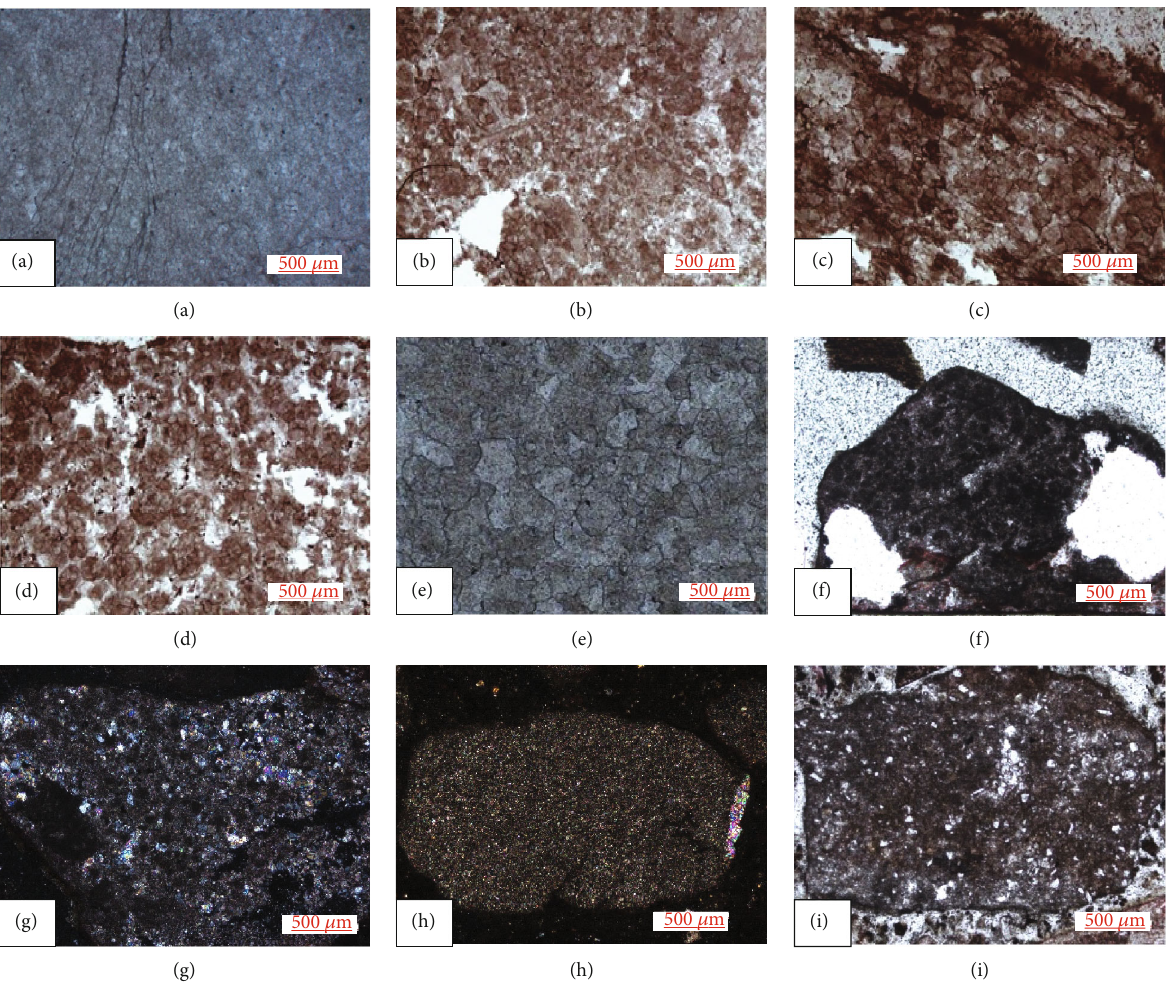
Figure 4: Petrological characteristics of dolomite in DEPS. (a) Muddy-pink dolomite, Wutan 1 Well, 6265 m, Xixiangchi Formation, 10 × 5(-), chip stained thin section; (b) fi ne-crystal dolomite, residual grain phantom, dissolved pores, quartz crystal, Wutan 1, 6907m, 10 × 5(-); (c) fi ne-grained dolomite, oolitic phantom, intercrystalline pores, Wutan 1 Well, 6921 m, 10 × 5(-); (d) oolitic dolomite, with intergranular and intergranular (dissolved) pores, asphalt impregnation, fi ne-grained structure, Wutan 1 Well, 6916m, 10 × 5(-); (e) residual oolitic dolomite, Loutan 1 Well, 6903 m, 10 × 5(-); (f) sandy dolomite, Wutan 1 Well, 6562m, Xixiangchi Formation, 10 × 5(-), cuttings stained thin section (g) gypseous dolomite, Loutan 1 well, 5325m, (+); (h) gypsum-bearing dolomite, Loutan 1 well, 5665m (+); and (i) gypsum-bearing dolomite, Wutan 1 Well, 6618m